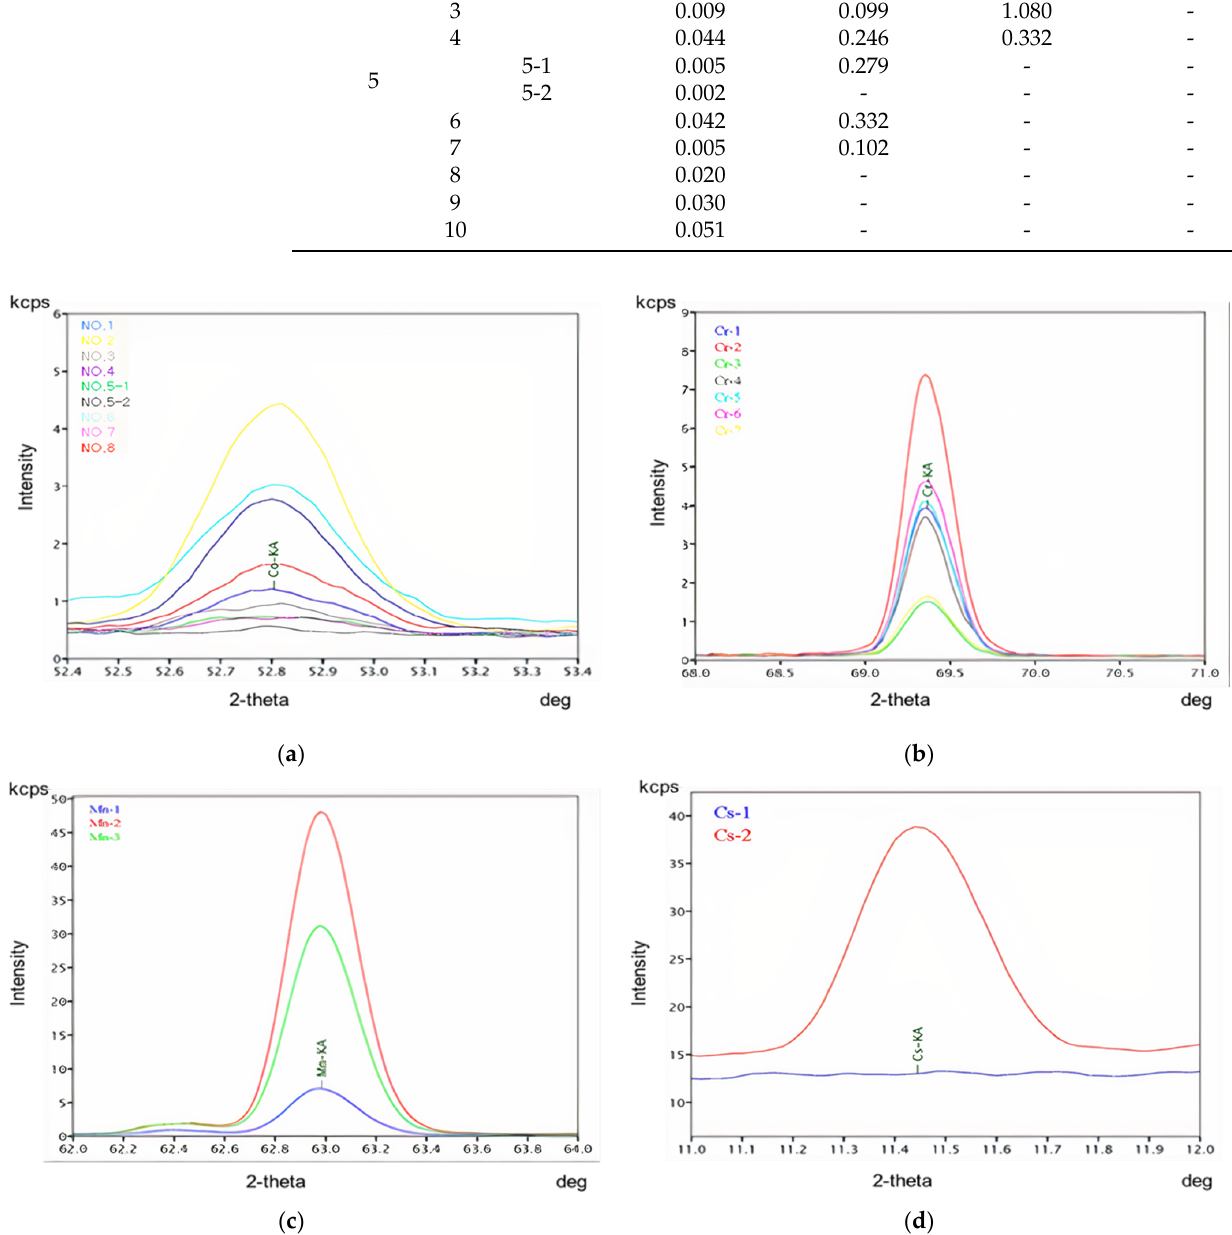
Figure 2. XRF analysis result. ( a ) Result of Co; ( b ) result of Cr; ( c ) result of Mn; ( d ) result of Cs. Table 5. Percentage of the surrogate nuclides captured in the slag. Using Equation (1), it is possible to calculate the absolute number of surrogate nuclides that migrated onto the slag after melt decontamination through the XRF analysis results in Table 4. The calculated results are summarized in Table